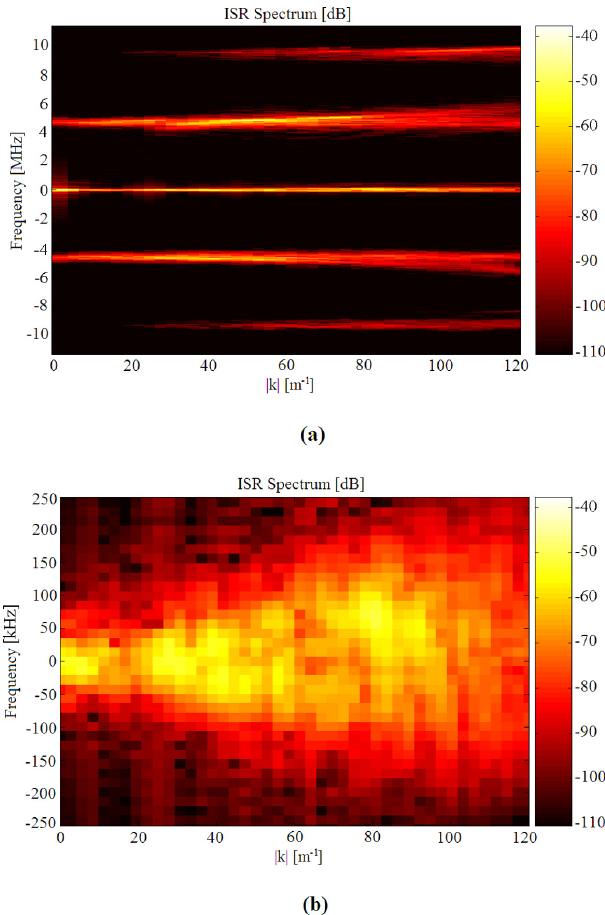
of the incoherent scatter spectrum for simulations with parameters presented in Sect.